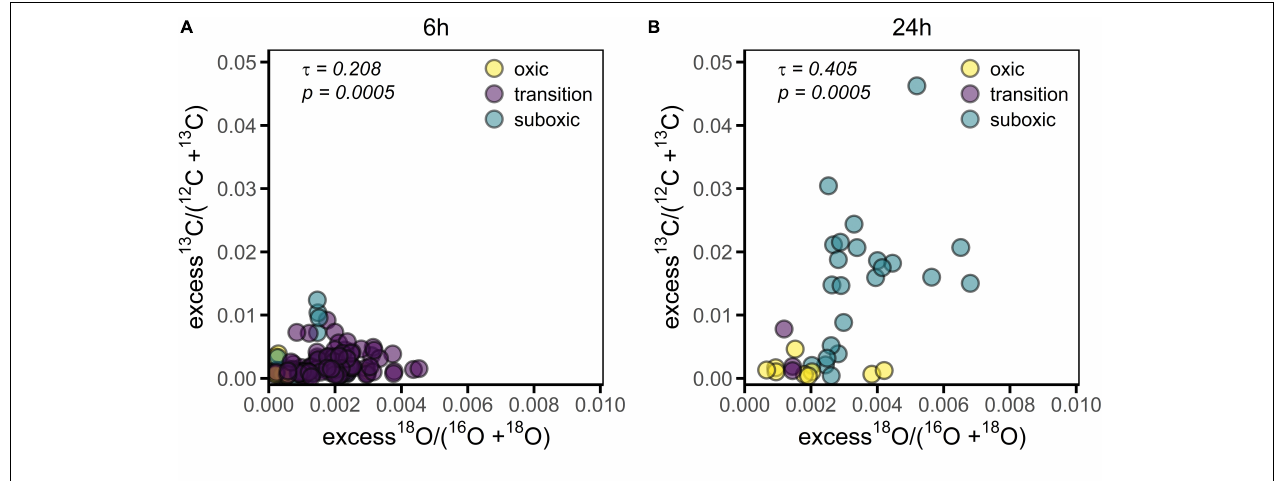
FIGURE 5 | 13 C labeling of the cell cytoplasm versus 18 O labeling of the poly-P granules in cable bacteria. Each data point represents a mean value for an individual filament segment. (A) Values obtained for filaments incubated for 6 h ( n = 129). (B) Values obtained for filaments incubated for 24 h ( n = 35). Colors differentiate among redox zones. Kendall’s correlation coefficient ( τ ) and the corresponding p -value are also shown.